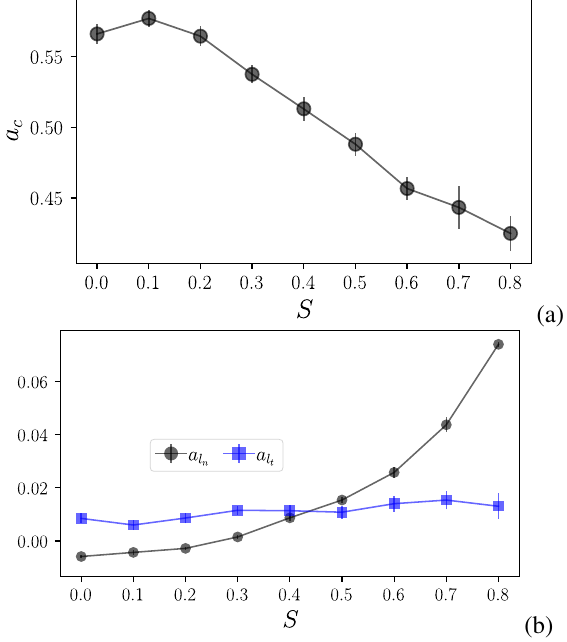
Figure 4. (a) Contact orientation anisotropy as a function of S at the steady state. (b) The normal and tangential branch anisotropies ( a ln , a lt ) as a function of the particle size span S . Bars present the standard deviation of the